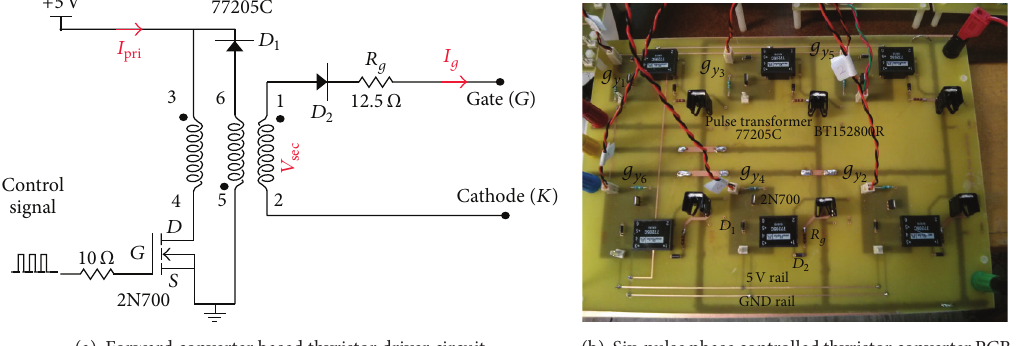
Figure 17: Forward converter based thyristor driver circuit and PCB